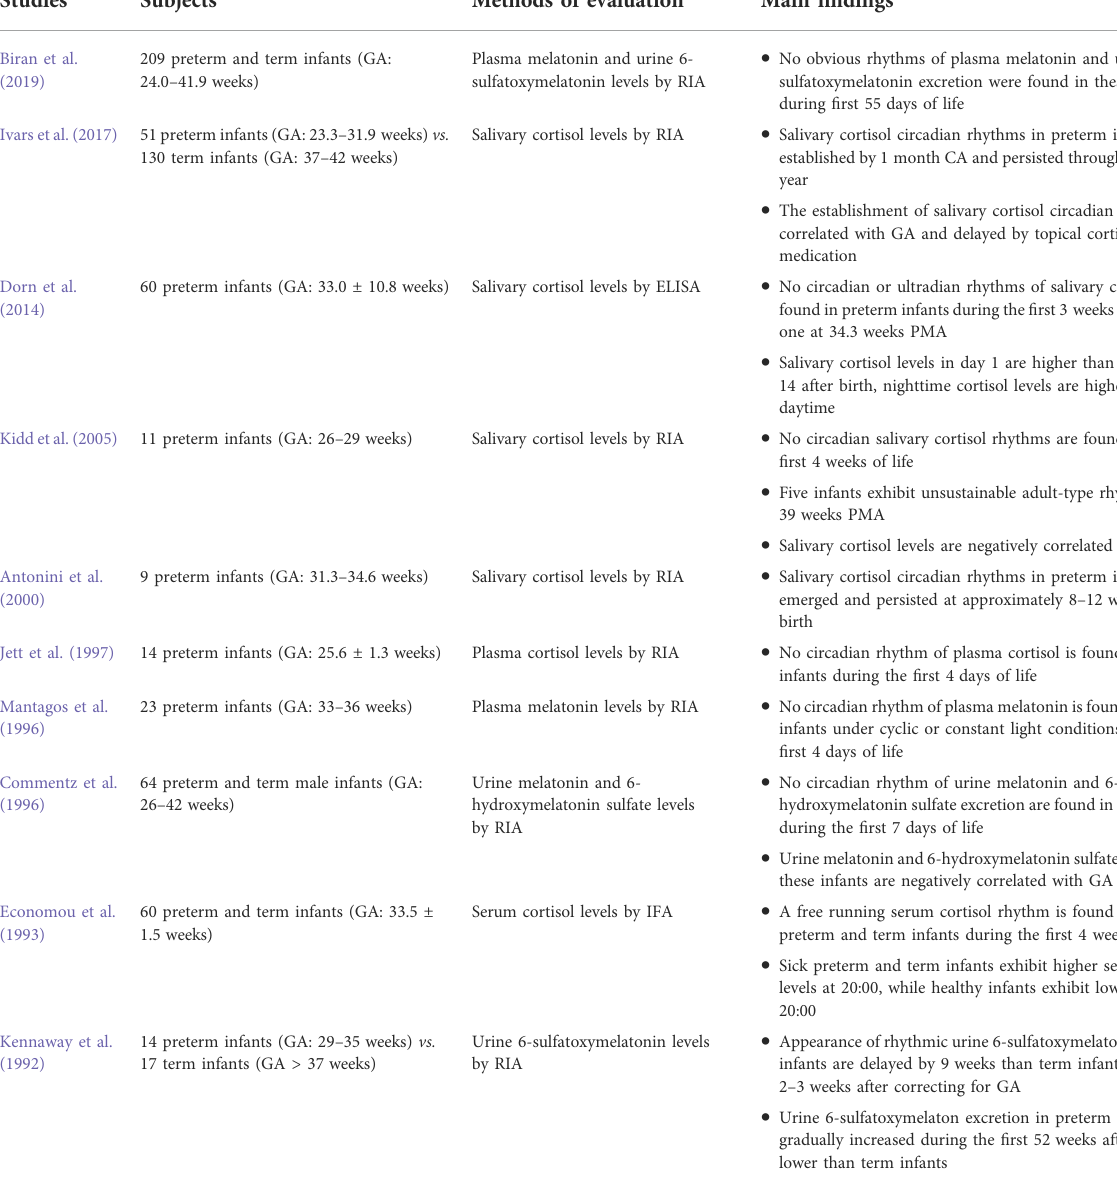
TABLE 4 Studies about the hormonal rhythms in preterm